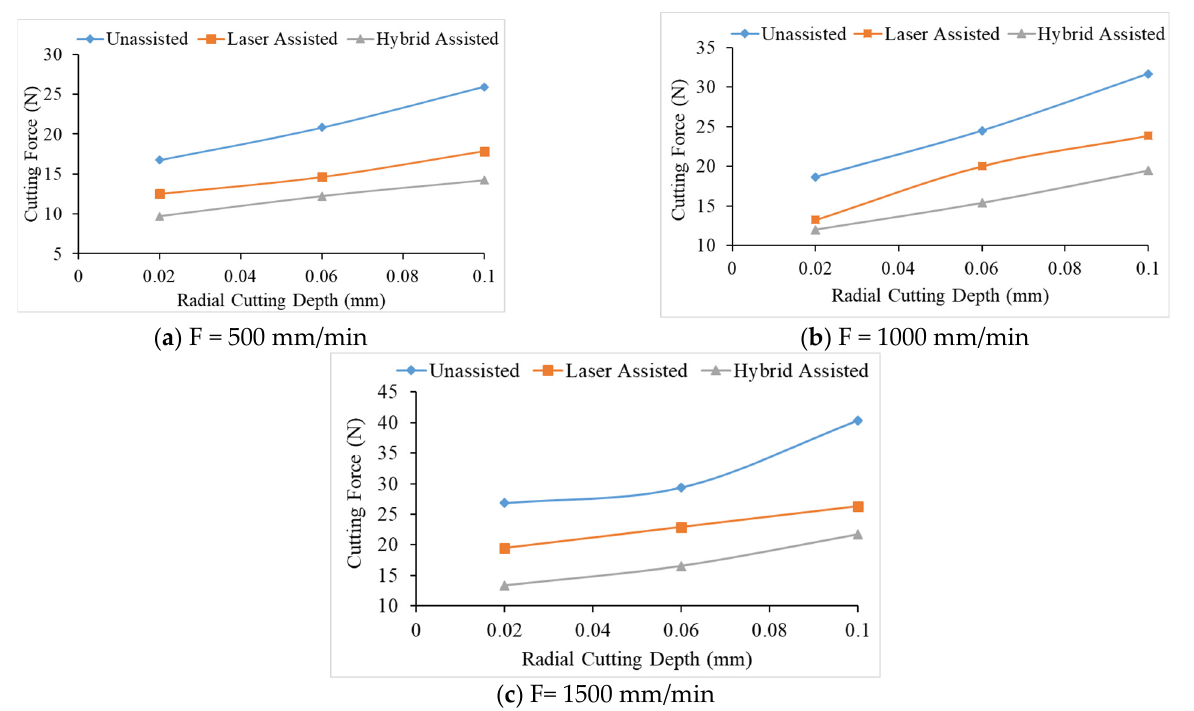
Figure 8. The relationship between the radial depth of cutting and cutting force under different feeds for unassisted, laser-assisted, and hybrid-assisted systems.